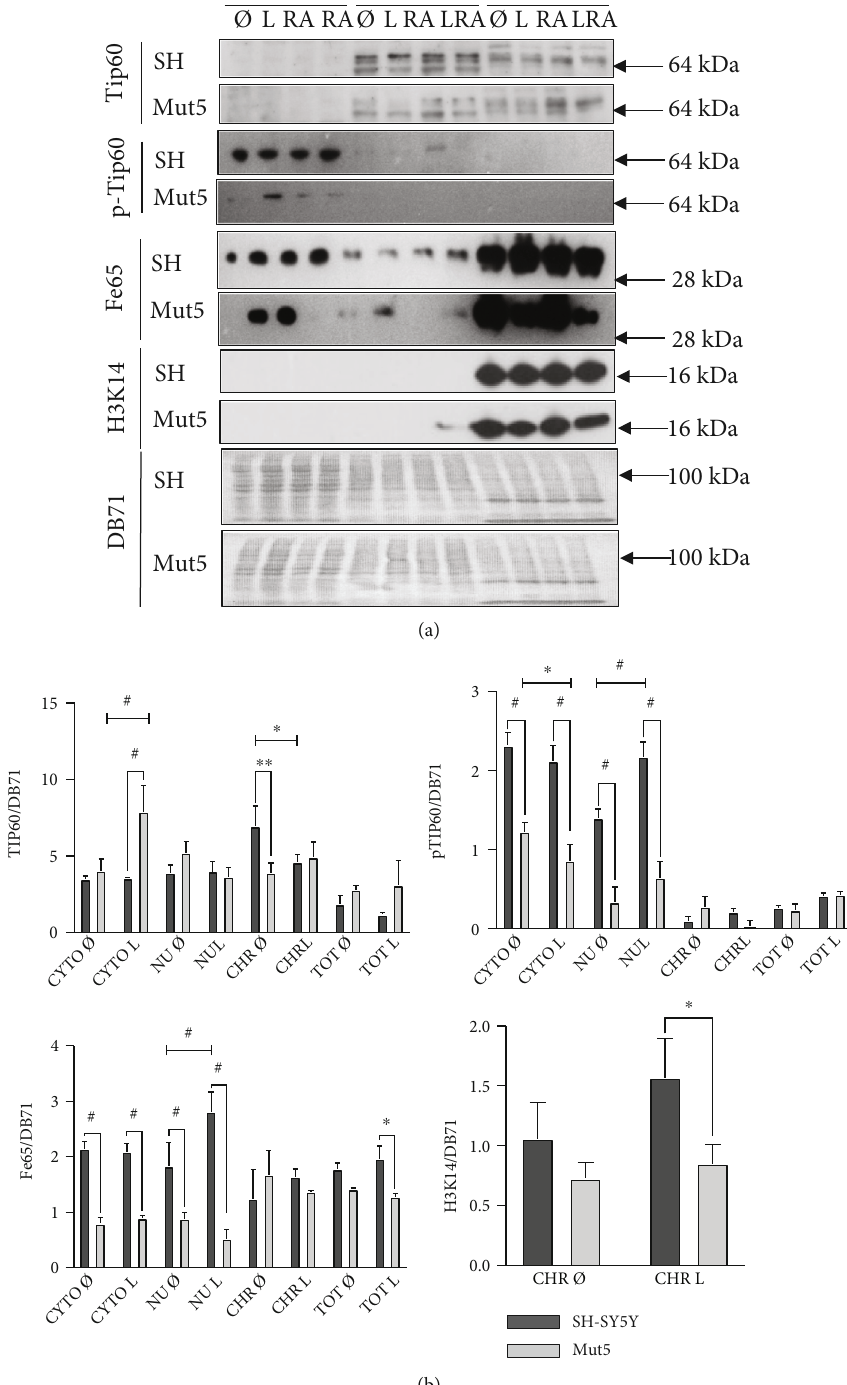
Figure 5: In (a), the SH-SY5Y cells (SH) and Mut5 clone were treated with leptomycin B (L), all-trans retinoid acid (RA), leptomycin B, and RA (LRA) for 30min, or not, collected and fractionated in cytoplasm (CYTO), nucleoplasm (NU), and chromatin (CHR). Proteins Tip60, phospho-Tip60 (pTip60), Fe65 (C-terminus), and acetylated H3K14 were then analyzed by Western blot. Equal loading was veri fi ed by DB71 staining. Overall, we observed higher expression levels of all proteins in the SH-SY5Y cells than in the Mut5 clone. (b) This experiment was repeated in triplicate with or without subcellular fractionation (Total, TOT) but with Fe65 (N- instead of C-terminus) and only the leptomycin B treatment. Statistical analyses mainly revealed higher expressions of the proteins studied in the NU and CYTO fractions of the SH-SY5Y cells, compared to the Mut5 cells. ANOVA with Tukey ’ s multiple comparison test: ∗ p < 0 : 05 ; ∗∗ p < 0 : 01 ; # p < 0 : 001 , n = 3